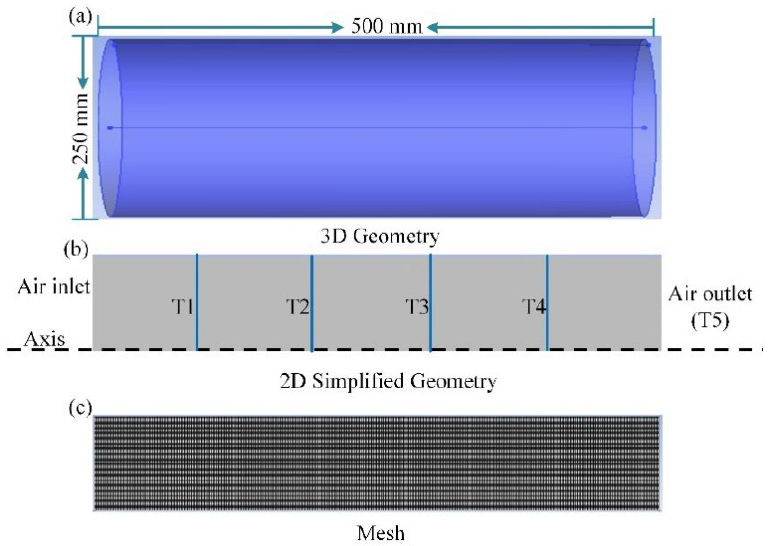
Figure 4. Fixed-bed reactor. ( a ) Three-dimensional geometric model; ( b ) two-dimensional geometric model; ( c ) computational mesh.